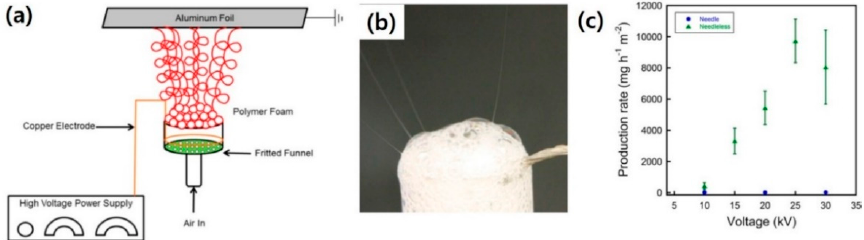
Figure 4. ( a ) Schematic illustration of foam based electrospinning, ( b ) photograph of fiber generation from the foam surface, and ( c ) Nafion nanofiber production rate of traditional electrospinning and foam based needleless electrospinning. [Adapted with permission from 45. Copyright (2019) American Chemical